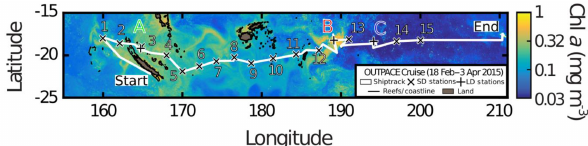
Figure 1. Transect of the OUTPACE cruise superimposed on quasi- Lagrangian-weighted mean Chl a of the WTSP during OUTPACE (see details in Moutin et al., 2017), with the two types of sta- tions: short-duration stations 1 to 15 ( × ) and long-duration sta- tions A, B and C ( + ). Along the transect, zooplankton samples were collected once at each short-duration station, whereas day– night sampling was performed each day at three strategic long- duration stations. Longitude is expressed as ◦ E. OUTPACE cruise (https://dx.doi.org/10.17600/15000900, Moutin et al.,